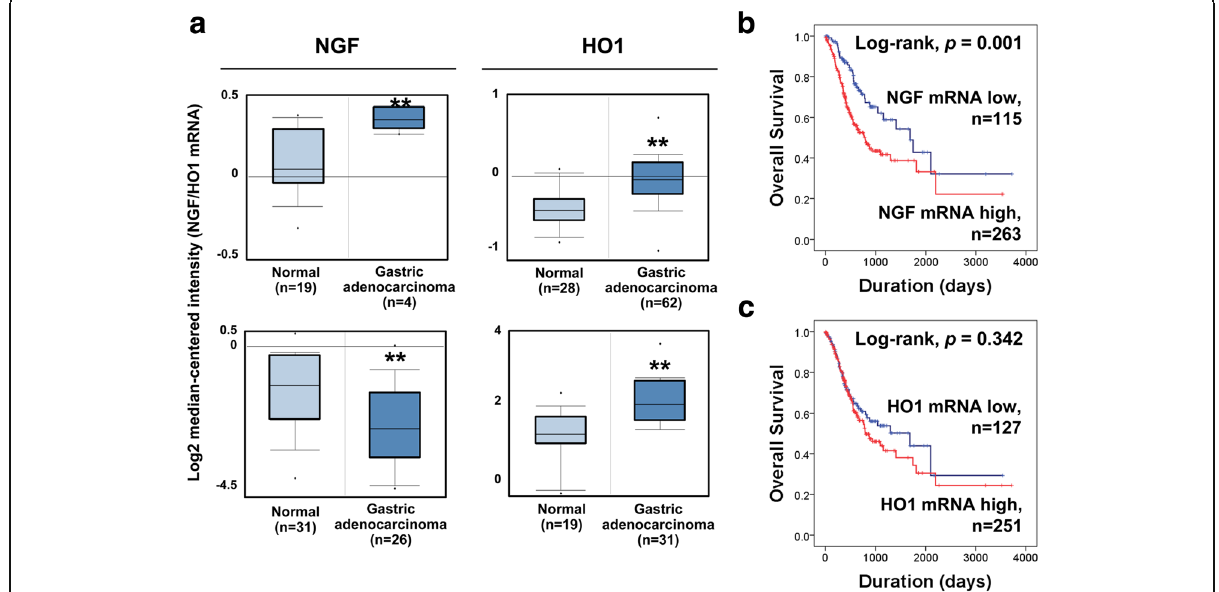
Fig. 5 The mRNA expression of NGF and HO1 in normal gastric tissue and gastric carcinoma and their prognostic impact. a The expression of mRNA of NGF and HO1 in normal gastric mucosa and gastric carcinoma obtained from the Oncomine database (https://www.oncomine.org. Accessed 22 April 2017). b Kaplan-Meier survival analysis according to the mRNA expression of NGF and HO1 in gastric carcinomas. The survival data obtained by a search of the OncoLnc database (http://www.oncolnc.org. Accessed 22 April 2017)